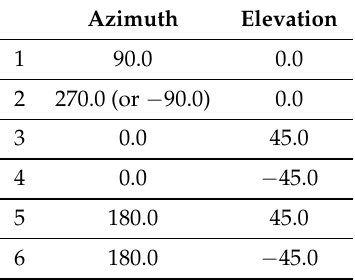
Table 1. Angle selection for training, validation and testing.